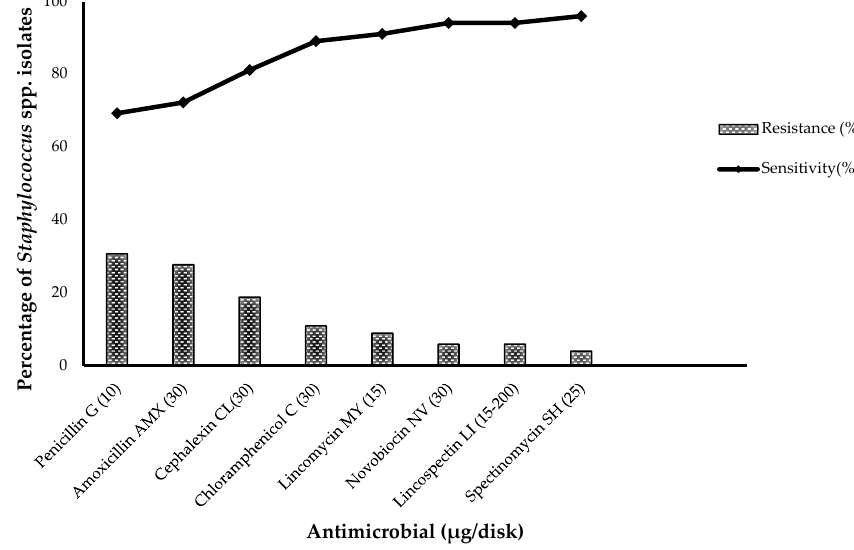
Figure 1. Susceptibility and resistance pattern of Staphylococcus spp. towards antimicrobials in the disk diffusion assay.